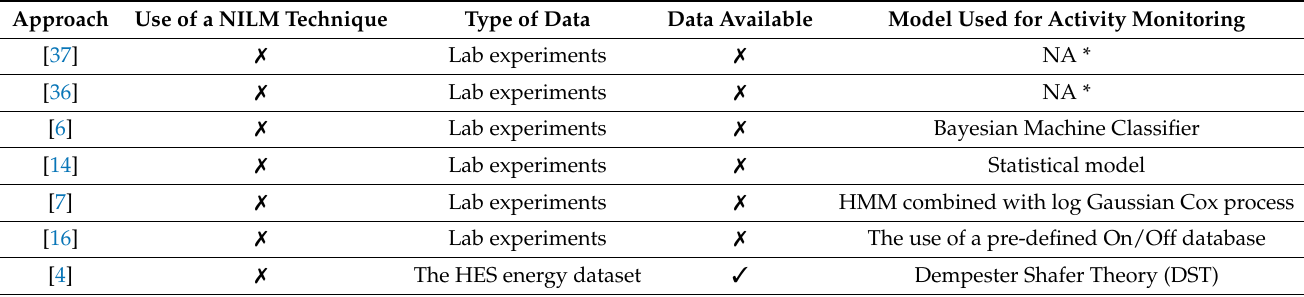
Table 2. Recent activity monitoring approaches based on energy